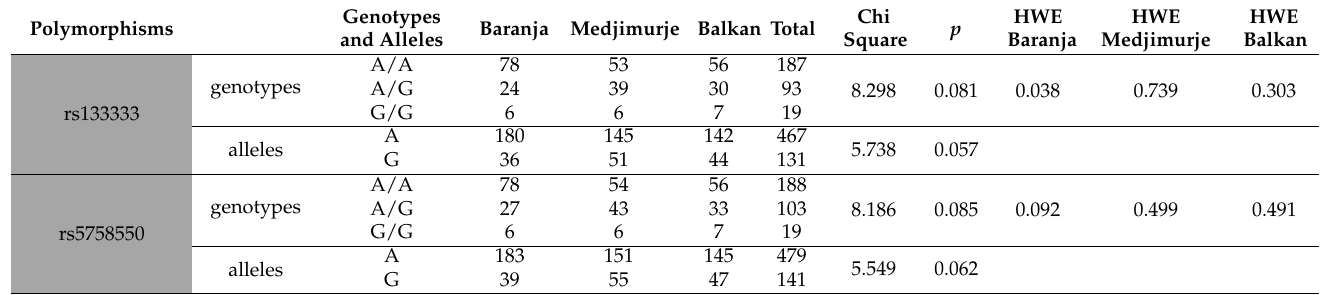
Table 1. Genotype and allele frequencies of 16 CYP2D6 promoter and 2 enhancer SNPs in the three Croatian Roma samples (Baranja, Medjimurje and